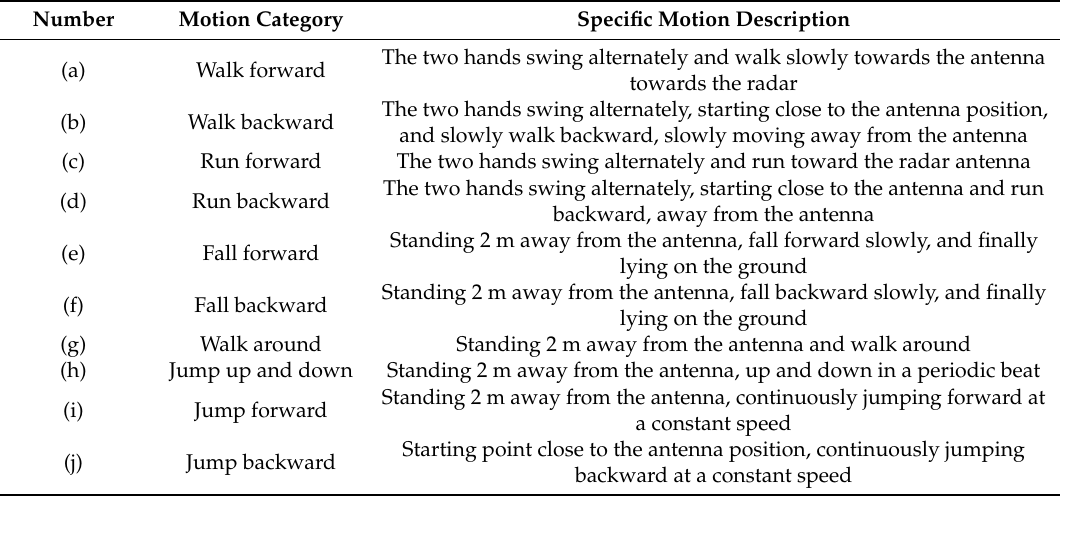
Table 2. Specific ten di ff erent types of human motion description.